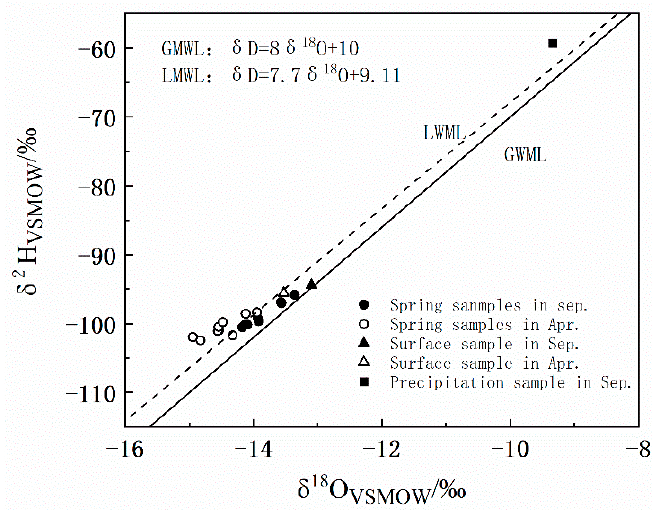
Figure 7. δ D– δ 18 O Plot of water samples.